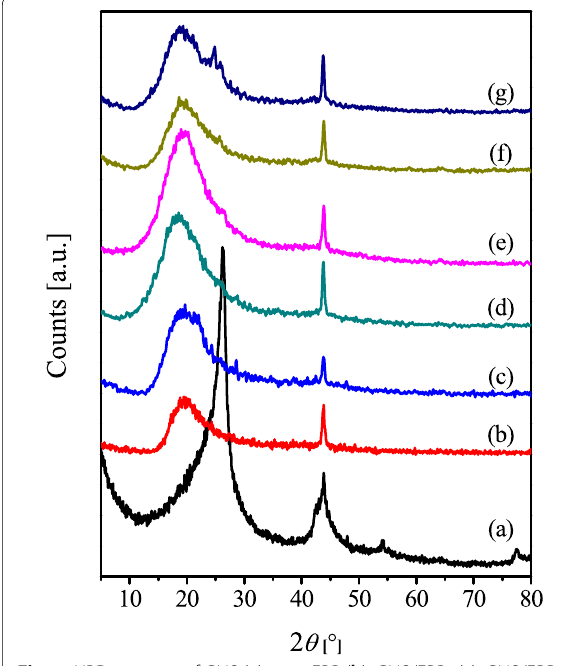
Fig. 1 XRD patterns of GNS ( a ), neat EPR ( b ), GNS/EPR 1 ( c ), GNS/EPR 2 ( d ), GNS/EPR 3 ( e ), GNS/EPR 4 ( f ) and GNS/EPR 5 ( g )